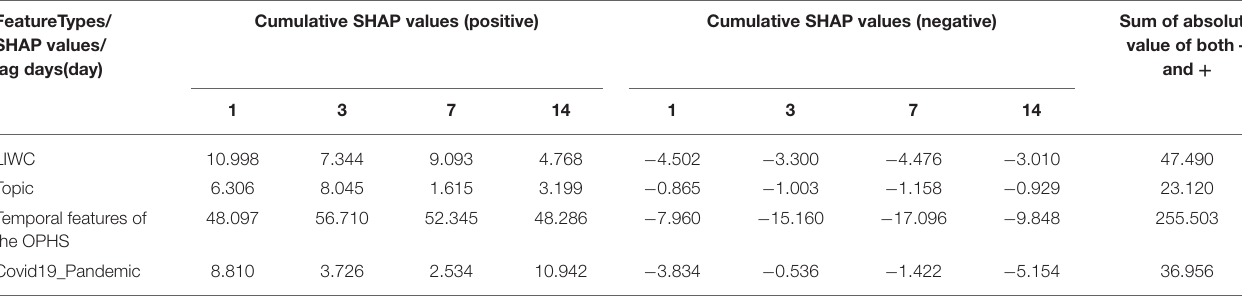
value of both – and